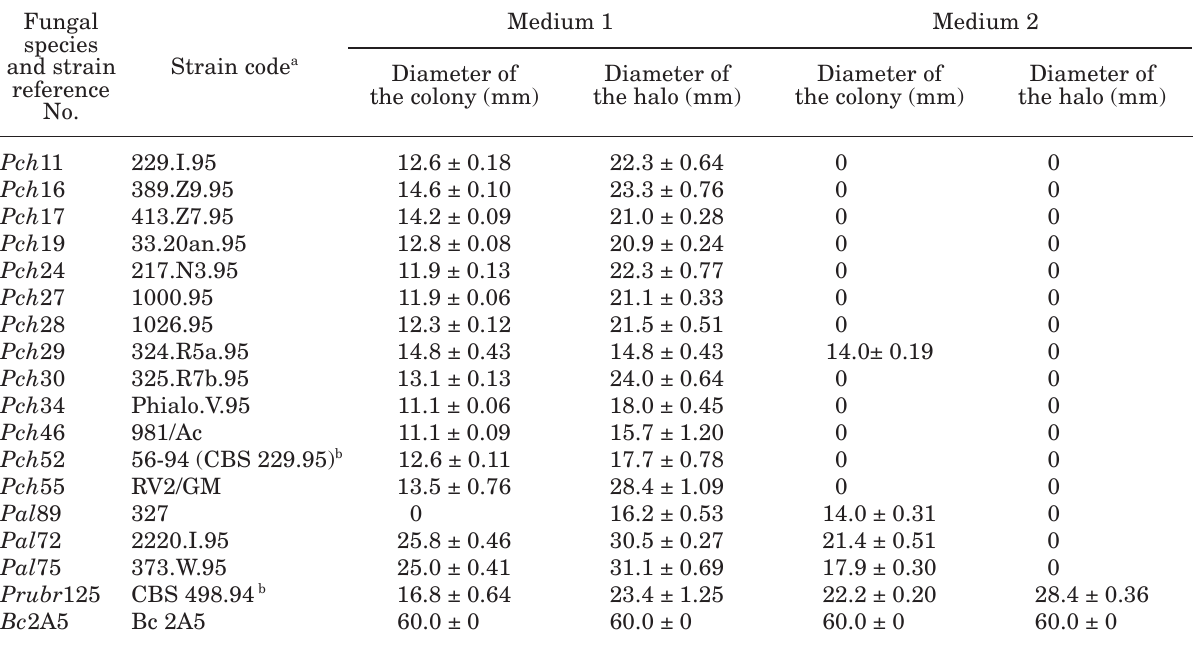
Table 1. Average diameter (mm) of 7-day-old colonies of Phaeomoniella chlamydospora ( Pch ) strains grown on the medium of Erikksson and Petterson (EPA) variously modified and supplemented with sodium salt of polygalac- turonic acid (Medium 1) or citrus pectin (Medium 2). The diameter of the colonies of Phaeoacremonium aleophilum ( Pal ), P. rubrigenum ( Prubr ) and Botrytis cinerea (Bc) are also shown. All media were inoculated with a 5-mm agar plug each. Data are average ± SE from 8 replicates. After 7 days of incubation at 25°C the plates were flooded with CTBA and the diameter of the halo produced by the reagent was measured (in mm, including colony diameter).